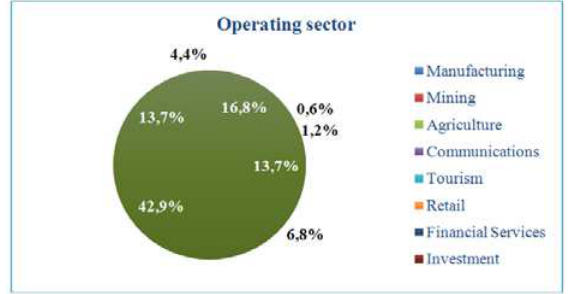
Fig. 7. Operating sector of